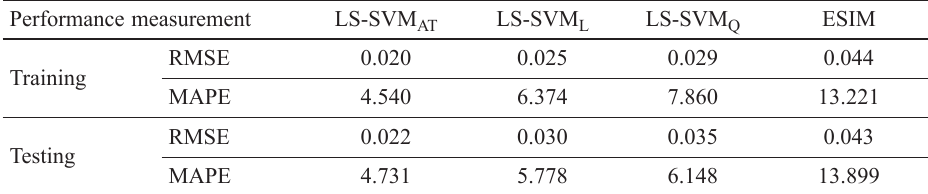
Table 2. Result comparison Performance